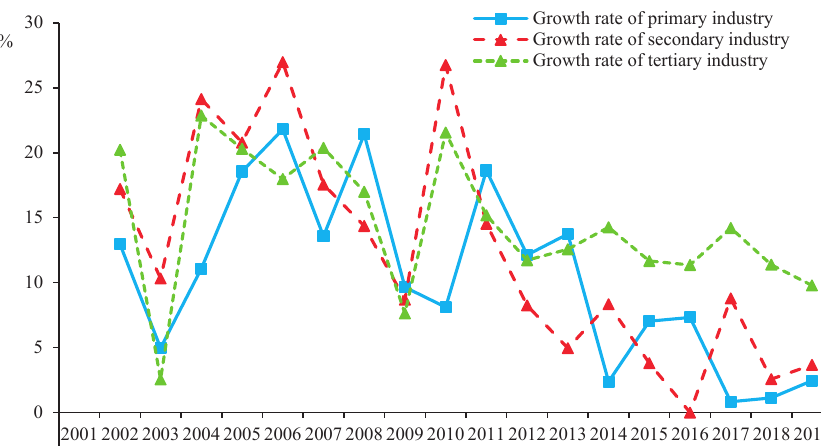
Figure 10. Growth trend of